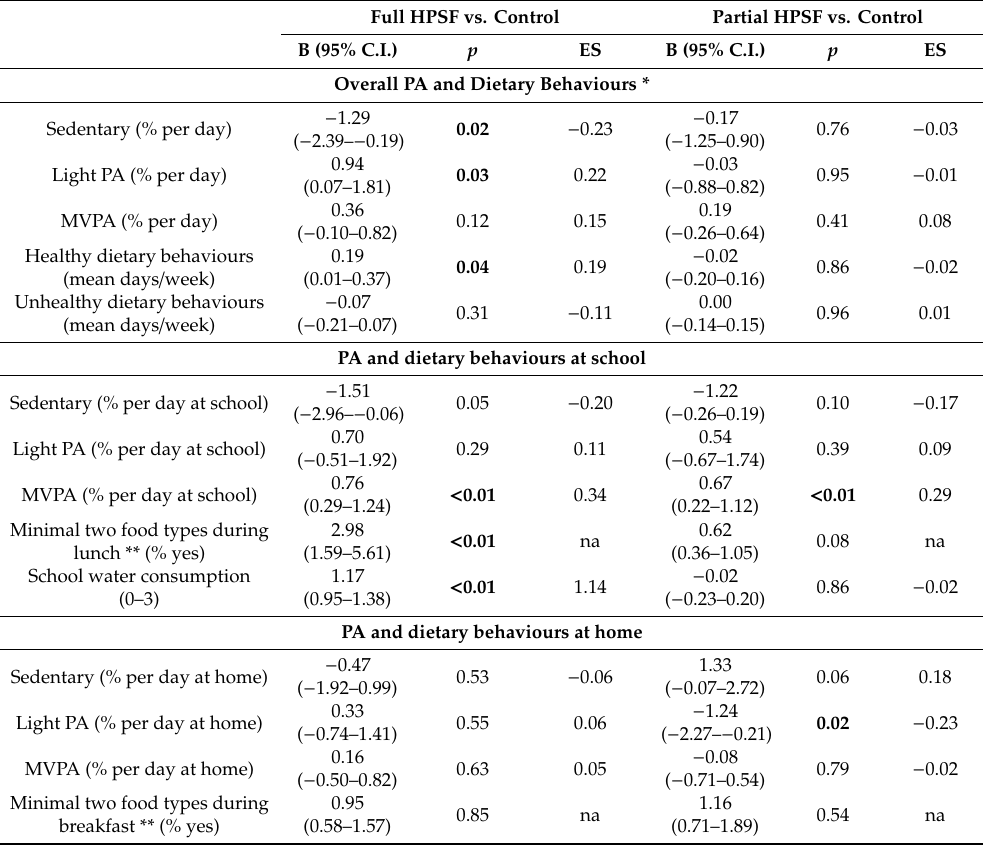
Table 1. Intervention e ff ects of Healthy Primary School of the Future (HPSF) at school and at home. Full HPSF vs. Control Partial HPSF vs. Control B (95% C.I.) p ES B (95%